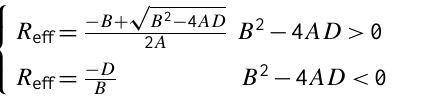
Fig. 2. Variations of F107, Dst and ap indices from May 6 to 12, 2008